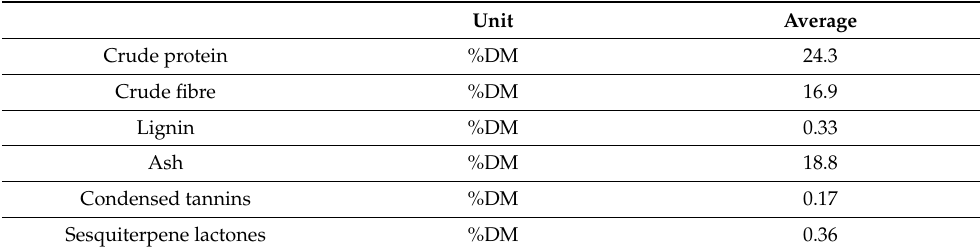
Table 3. Nutritional value of Cichorium intybus L.